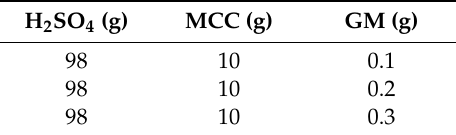
Table 1. Weight ratios of microcrystalline cellulose (MCC) and graphene materials (GM) for making cellulose nanocrystals (CNC) / GM sol mixtures through one-step